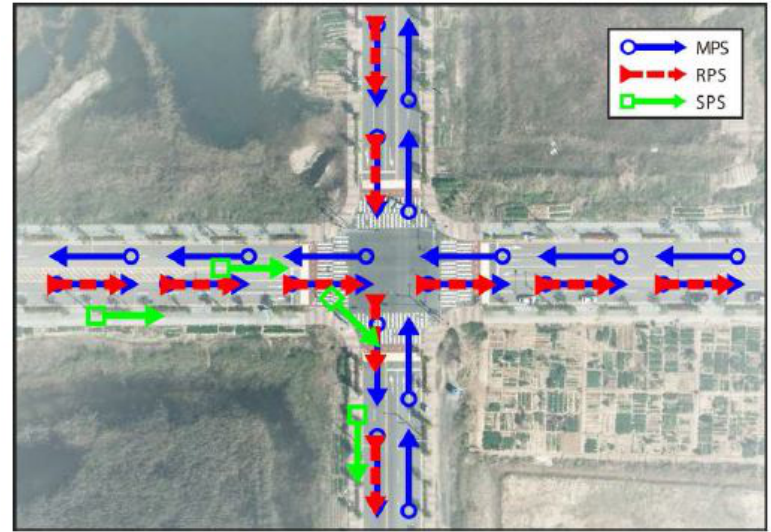
Figure 2. Examples of the RPS, SPS, and